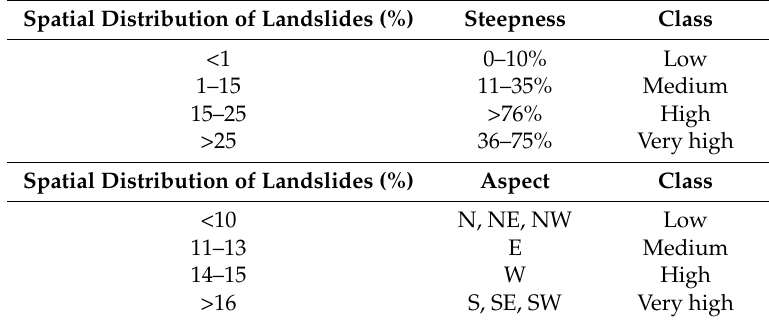
Table 5. Reclassification of the slope aspect and steepness values based on the spatial distribution of landslides in each category of slope steepness and aspect